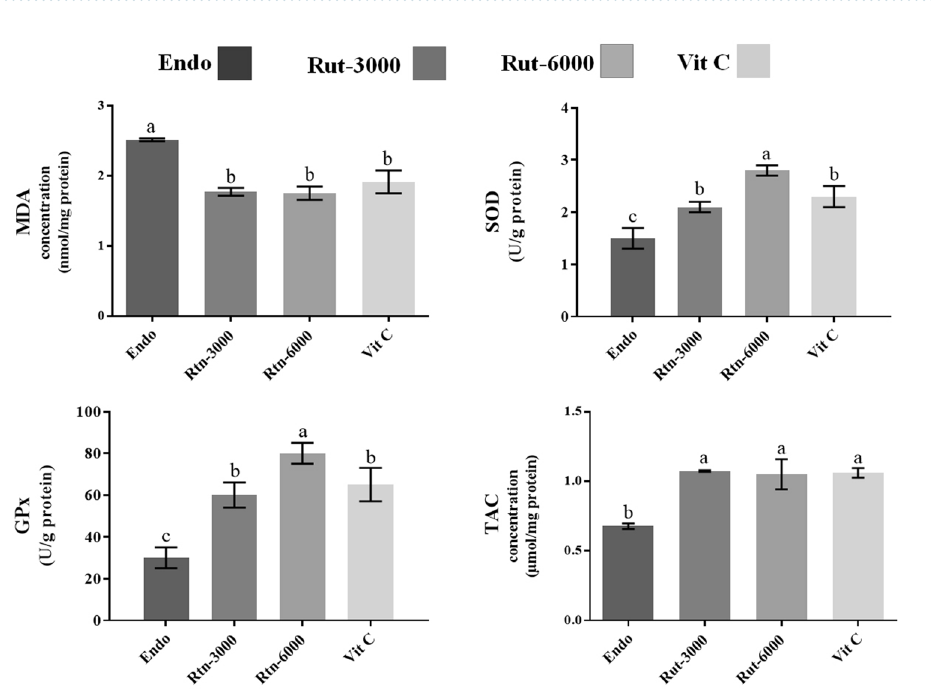
Figure 4. Determination levels of MDA, SOD and GPx and TAC in the different cells. Superscripts (a, b) show significant differences between groups at P <